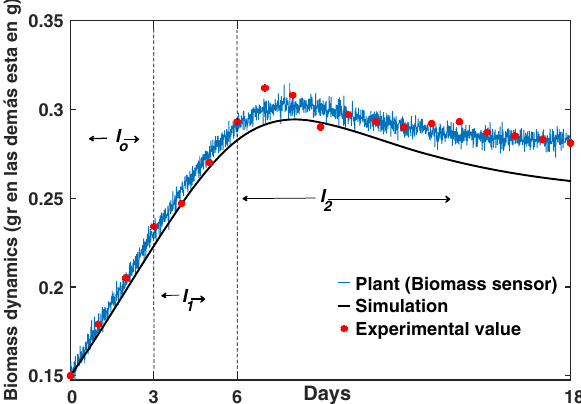
Figure 6: The biomass obtained experimentally is shown in black trace. The blue solid line shows the analog signal of the biomass sensor. The black solid line shows the simulation